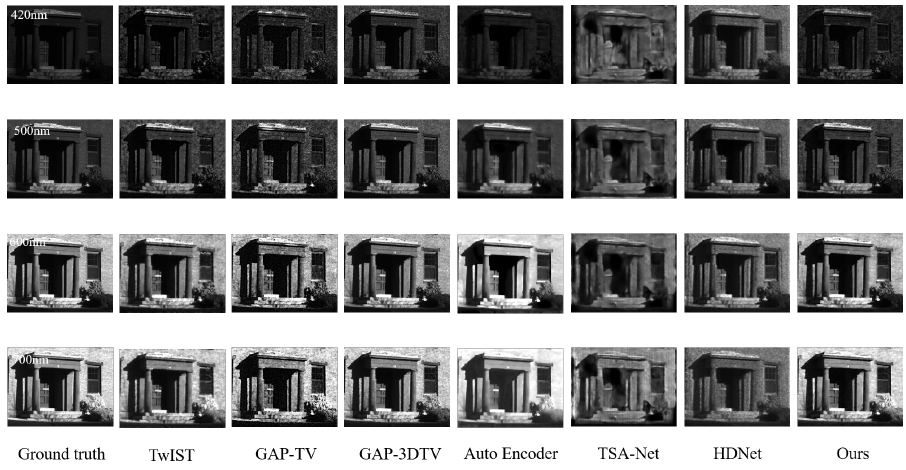
Figure 8. Reconstructed spectral images with a size of 1040 × 1392 from the Harvard dataset. We show the reconstructed results of four bands (wavelength: 420, 500, 600, and 700 nm) by different